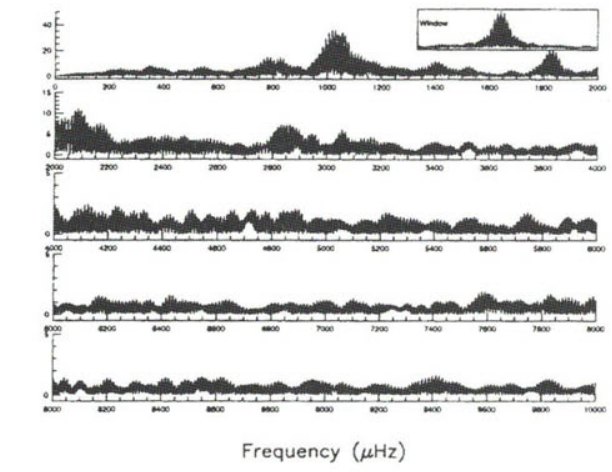
Fig. 15. The FT for the December 1993 data on G